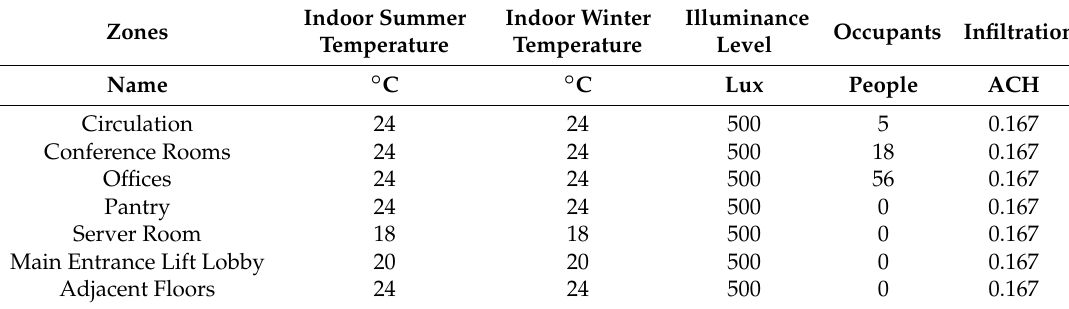
Table 1. Indoor design criteria.